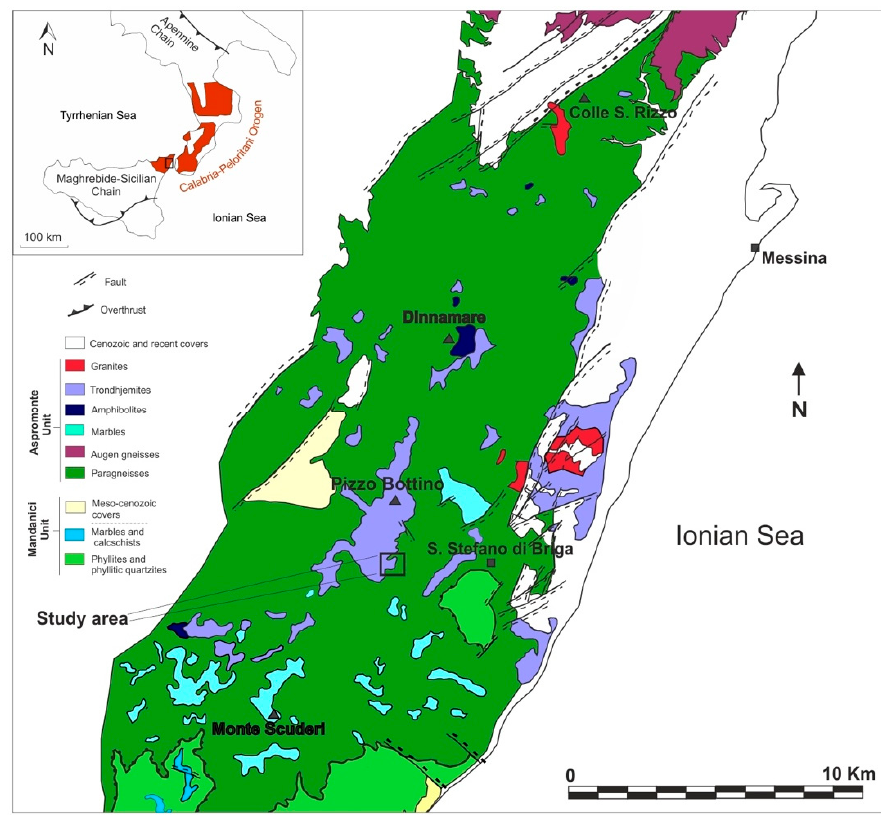
Figure 1. Geological sketch map of the north-eastern Peloritani Mountains (NE Sicily) with location of the studied migmatite outcrop (modified after [19]).